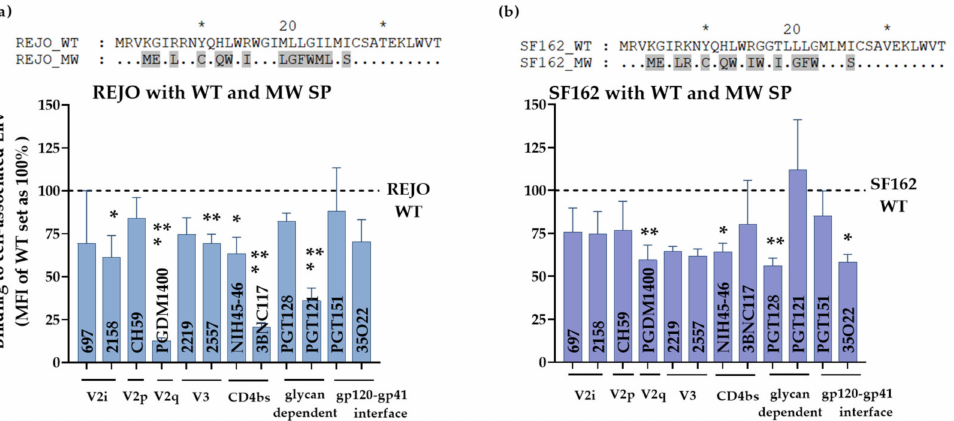
Figure 7. Effect of SP swap on REJO and SF162 Env-antibody interaction. HEK293T cells transfected with REJO ( a ) and SF162 ( b ) gp160 were analyzed for binding to mAbs targeting different Env epitopes. The mAbs were tested at following concentrations: 697, 830, and 3685 at 100 µ g/mL; 2G12 at 50 µ g/mL; PGDM1400, 2219, 2557, 240D, 98-6 and PGT121 at 25 µ g/mL; 4E10, 17b at 10 µ g/mL; PGT128, PGT151, 3BNC117 and CD4-IgG at 5 µ g/mL; CH59 and NIH45-46 at 2.5 µ g/mL. Normalized geometric mean fluorescence intensity (MFI) compared to WT (set as 100%) and SD from duplicates in one experiment are shown. MFI of negative control mAb were subtracted. Data were analyzed by ANOVA (*, p < 0.05; **, p < 0.01; *** p < 0.001; vs. WT). Sequence differences among the respective WT and swapped SP are also shown. Similar residues are shown as dot, * denote blocks of